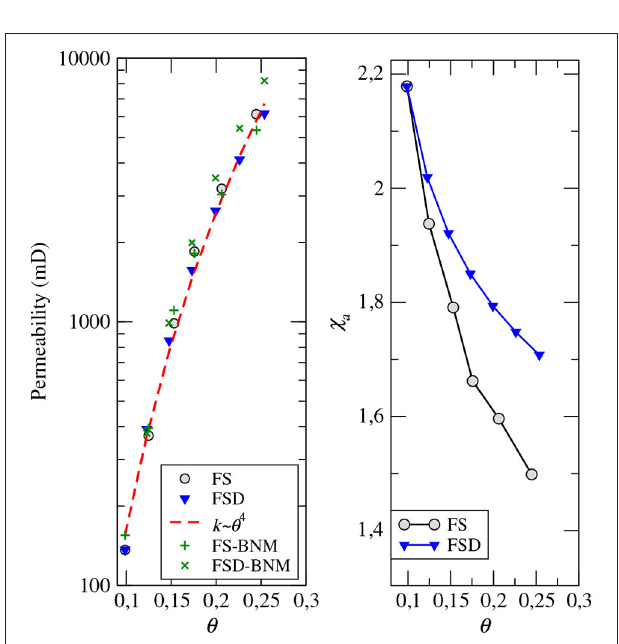
FIGURE 5 | Permeability (left) and advective tortuosity χ a (right) vs. porosity θ for the FS and FSD